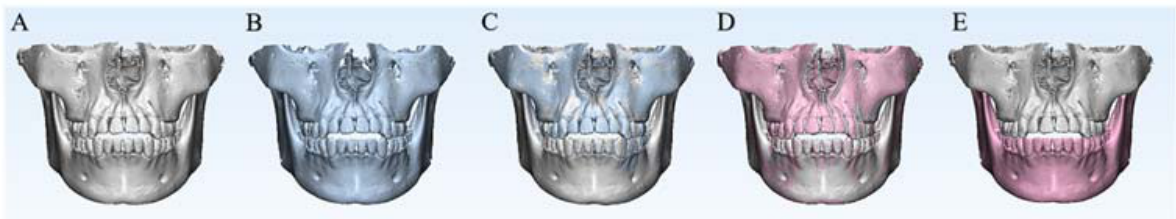
changes are shown in Figure 8A–C. tural